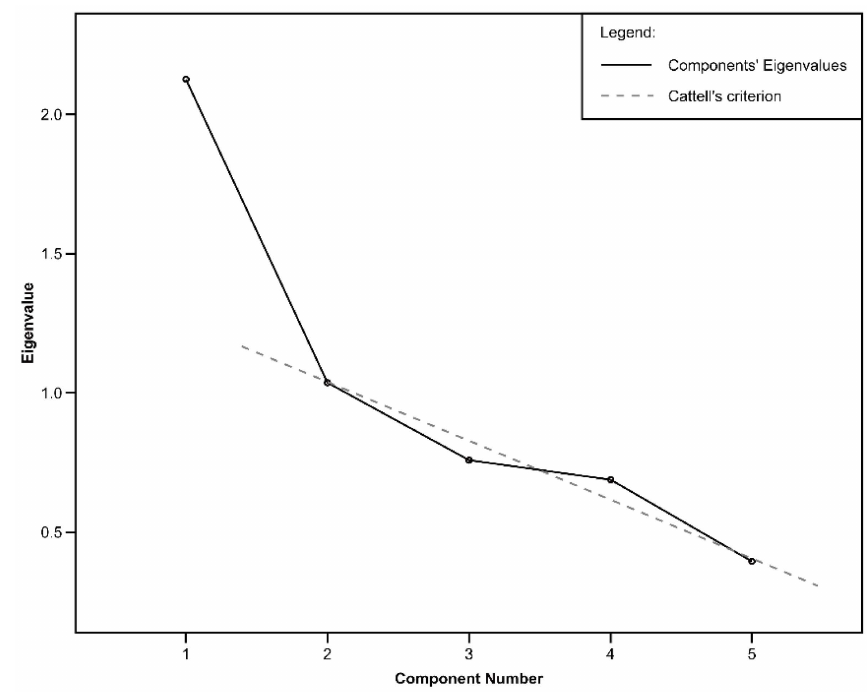
Figure 1. Scree plot for the five components of